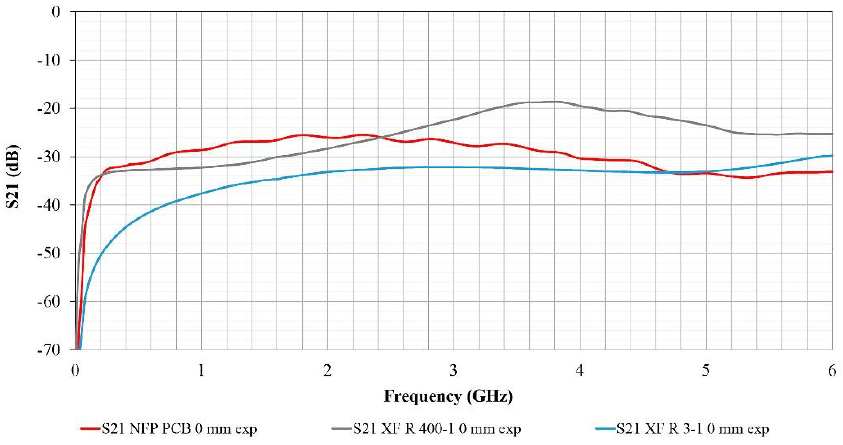
Figure 16. Comparison of the S 21 parameter measured with the NFP-PCB and the commercial probes.